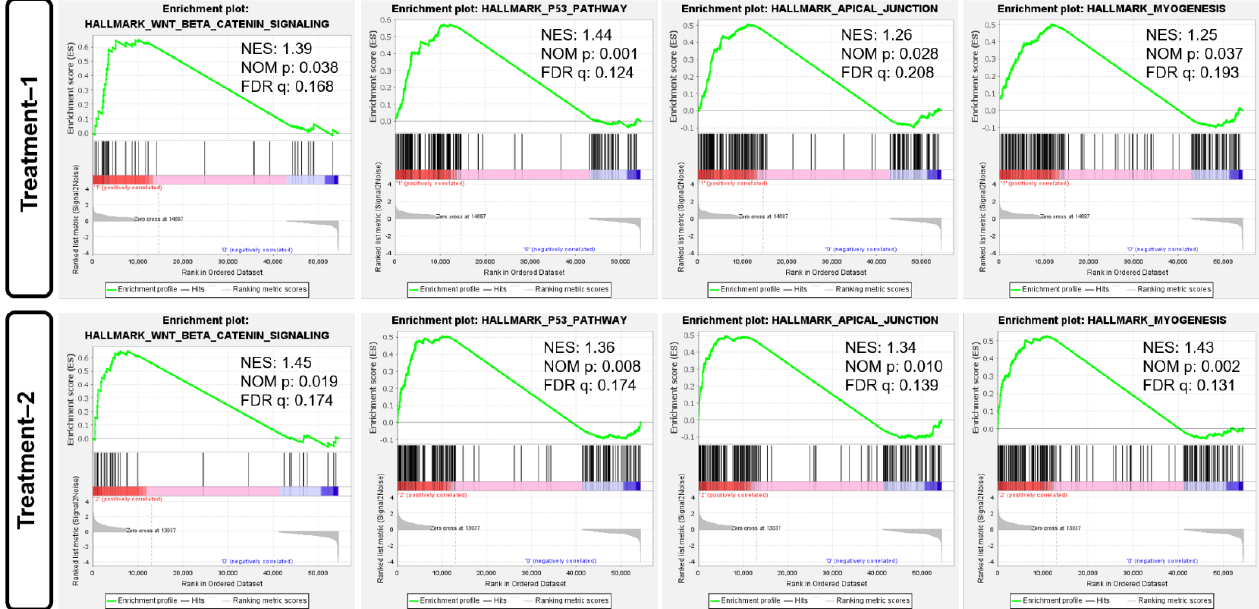
Figure 6. GSEA score profile of four enriched pathways depending on light treatment with two dosages: Hallmark_p53_pathway, Hallmark_Wnt_beta_catenin_signaling, Hallmark_Apical_junction, and Hallmark_Myogenesis. Threshold value to consider as significant difference is set as |normalized enrichment score (NES)| ≥ 1.0 and NOM p -value < 0.05 and FDR q-value < 0.25.